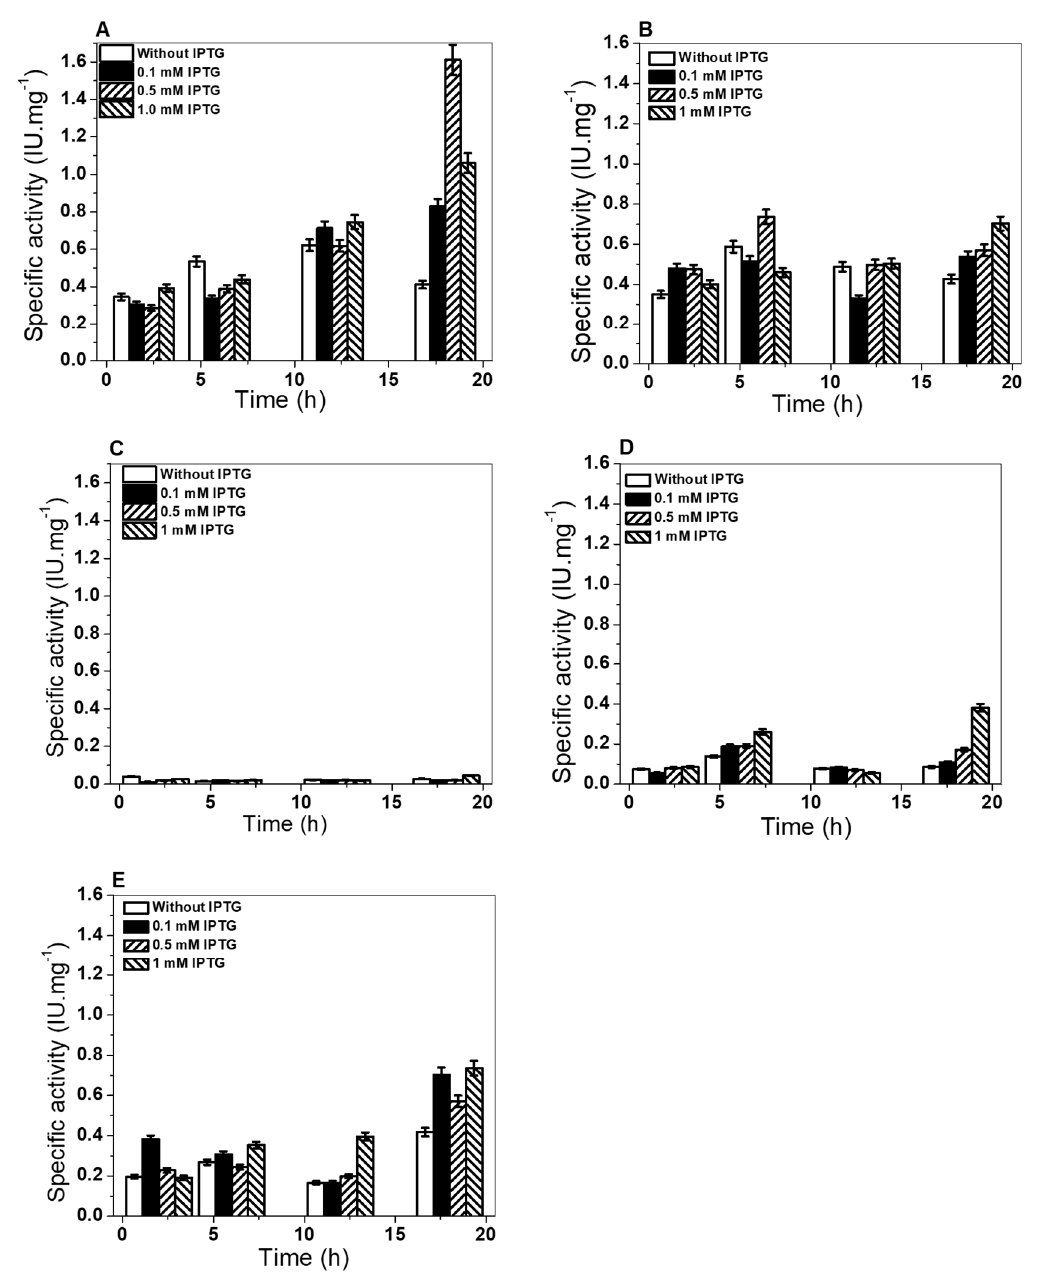
Figure 4. Overexpression of G6PD variants in a heterologous system. ( A ) G6PD WT human recombinant; ( B ) G6PD single mutant A+; ( C ) G6PD San Luis Potosi; ( D ) G6PD Guadalajara; ( E ) double G6PD mutant Monte Sinai. Crude extract was measured at 340 nm to calculate specific activity based on the concentration of protein of each culture. Assays were performed in triplicate.